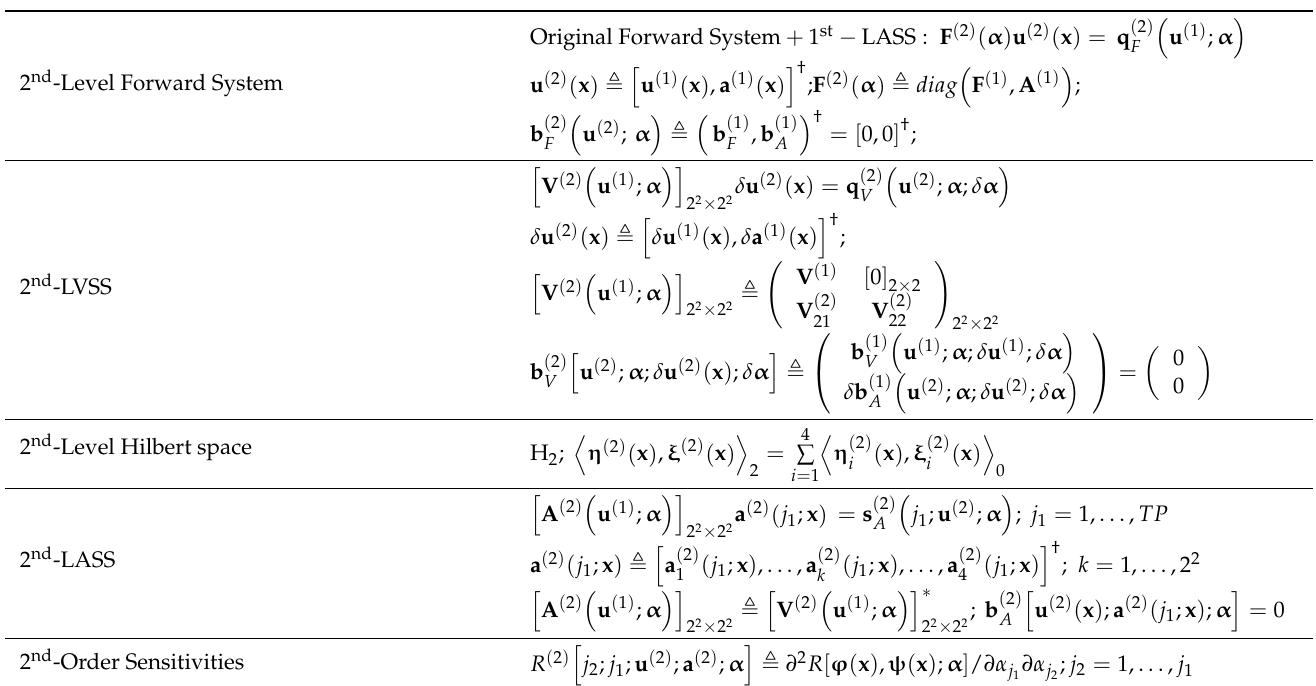
Table 2. Second-Order Sensitivities ( n =